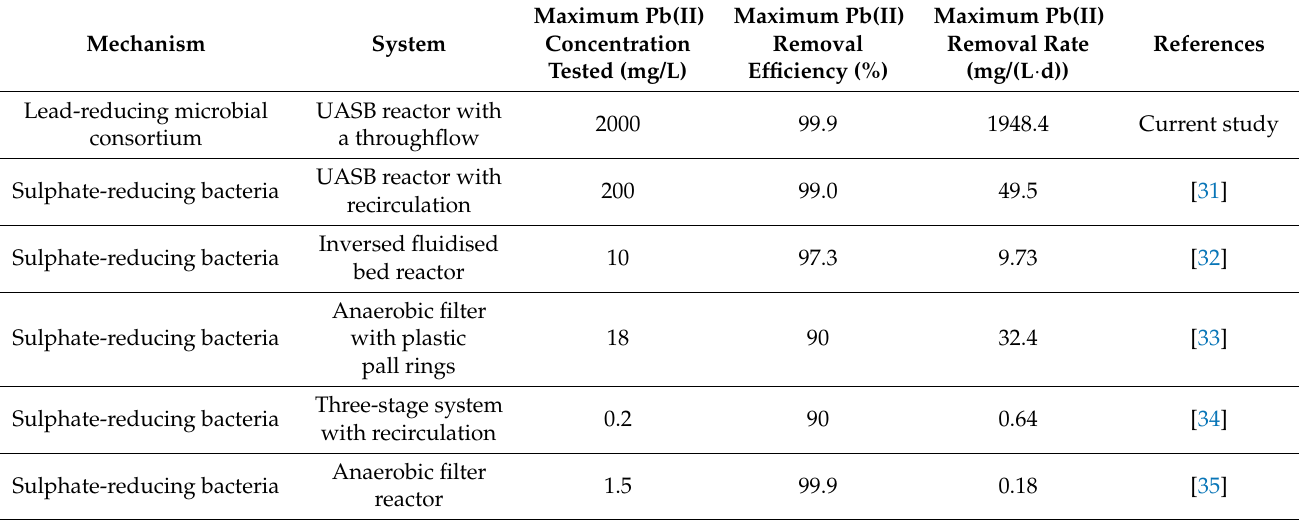
Table 1. Percentage removal efficiencies, removal rates and system types of various known